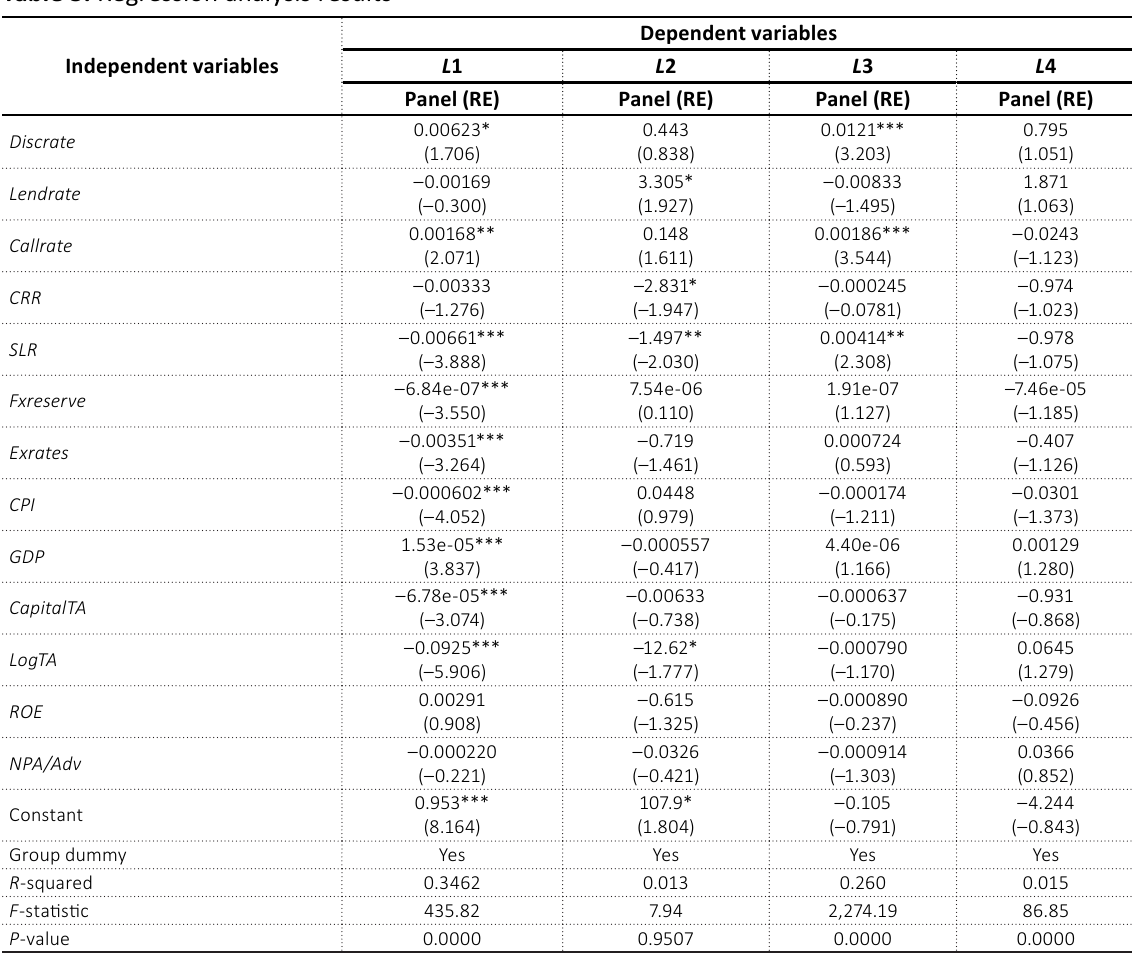
Table 3. Regression analysis